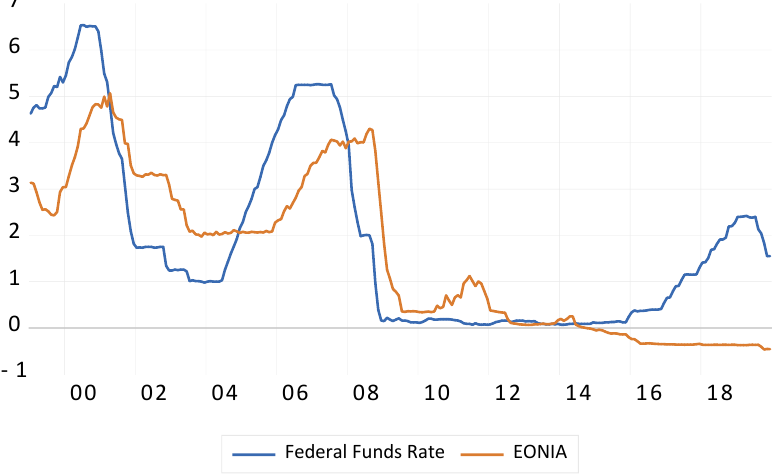
Figure 4. Evolution of Federal Funds Rate and EONIA over the sample period 1999:1–2019:12. Further, we must add that a decoupling between the two policy rates seems to have materialized only in more recent years.